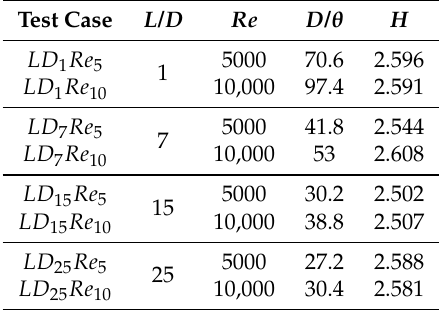
Table 1. The shear layer parameters at the nozzle exit for all the test cases